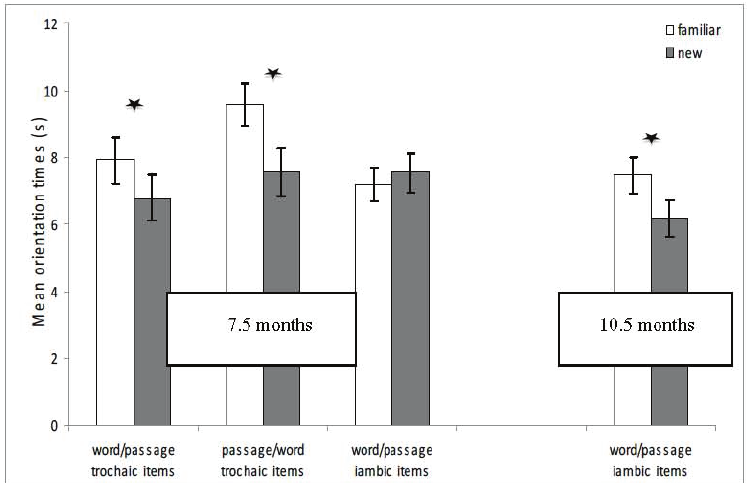
Figure 2: Mean orientation times (and standard error) to the test passages containing the familiar(ized) versus new items (for the word/passage order), or to the word-lists corresponding (familiar) or not (new) to the familiarized passages (for the passage/word order). Results are broken down by age (7- versus 10.5-month-olds) and item type (trochaic versus iambic